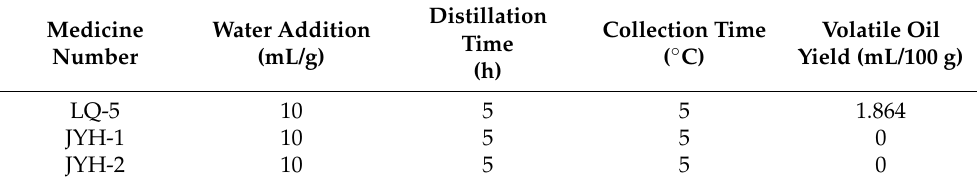
Table 6. Separate distillation of volatile oils from F. suspensa or L. japonica .